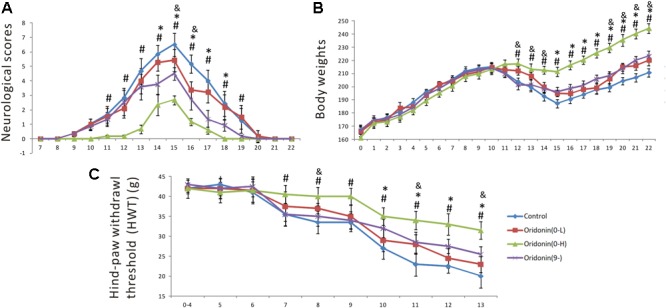
Preventive and therapeutic Oridonin treatments attenuated neurological disease severity, shortened disease duration and suppressed mechanical allodynia in EAN rats. EAN rats (n = 6) were orally administrated daily with Oridonin (7 or 20 mg/kg in CMC) or CMC alone (same volume), since Day 0 as preventive or since Day 9 (first neurological sign occurred) as therapeutic treatment. Neurological scores and body weights were recorded every day post-immunization. (A) Both preventive and therapeutic Oridonin treatments decreased neurological severity of EAN and shortened EAN duration. (B) Meanwhile, the reduction of body weights, which is also a characteristic sign of EAN, was significantly ameliorated by both therapeutic and preventive treatments with Oridonin. (C) The another characteristic neurological sign of EAN, mechanical allodynia, defined as reduction of HWT, was observed as early as Day 7 up to the end of the experiment (Day 13) in the control group. Either therapeutic or preventive treatment with Oridonin at high or low doses significantly restored the reductions. Significant differences of HWT among control, Oridonin therapeutic and preventive groups were confirmed. Finally, repeated ANOVA assays indicated significant difference between all the three groups, in neurological scores, body weight time courses and HWT. ∗p < 0.05 comparison of the preventive treatment group to the control group, &p < 0.05 comparison of the preventive treatment group at 7 mg/kg to the control group, #p < 0.05 comparison of the therapeutic treatment group to the control group, n = 6.